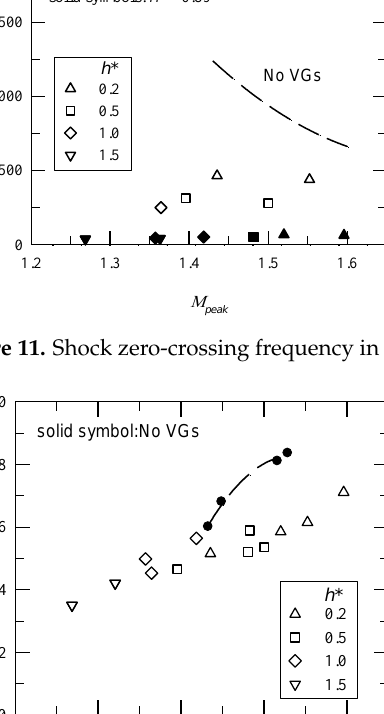
Figure 10. A sketch for two-threshold method. symbols: M = 0.83 solid symbols: M = 0.89